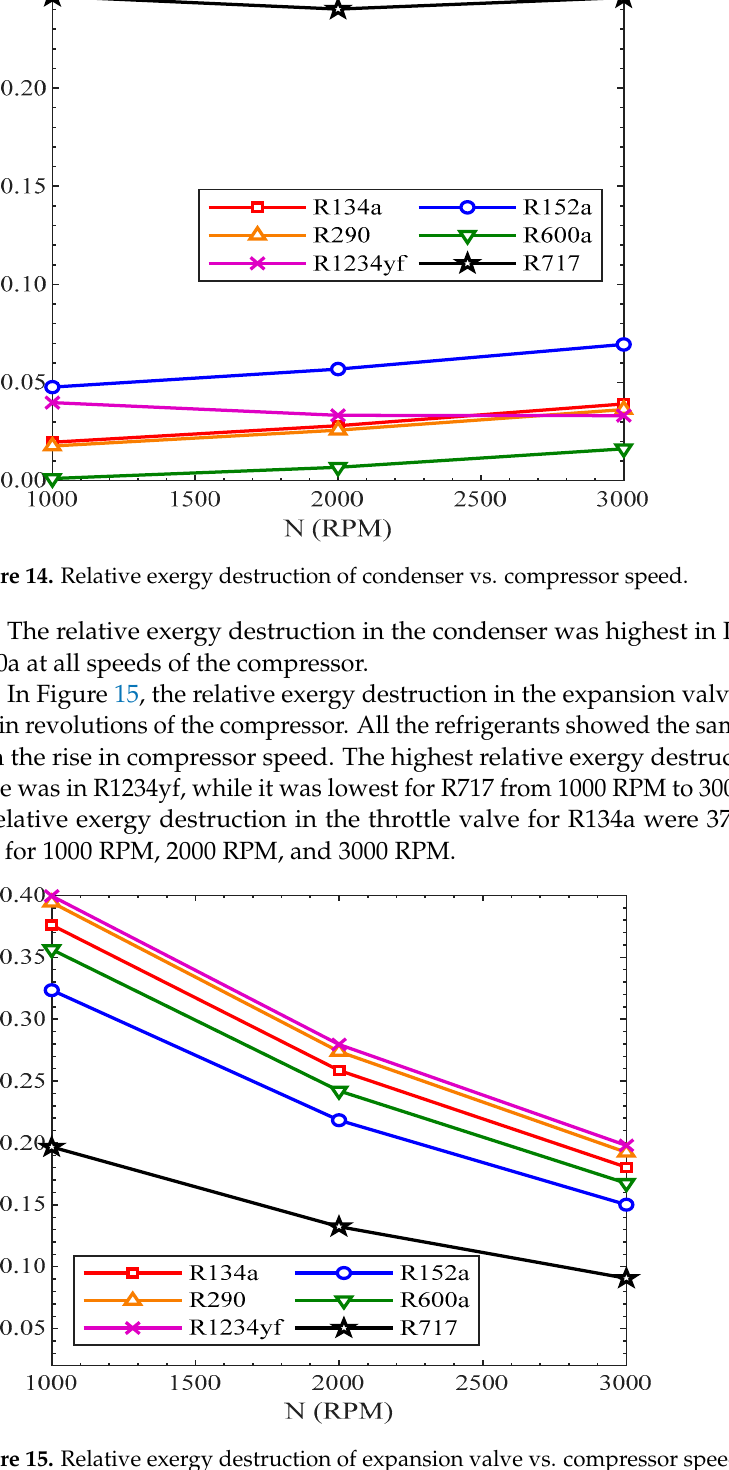
Figure 15 . Relative exergy destruction of expansion valve vs. compressor speed .